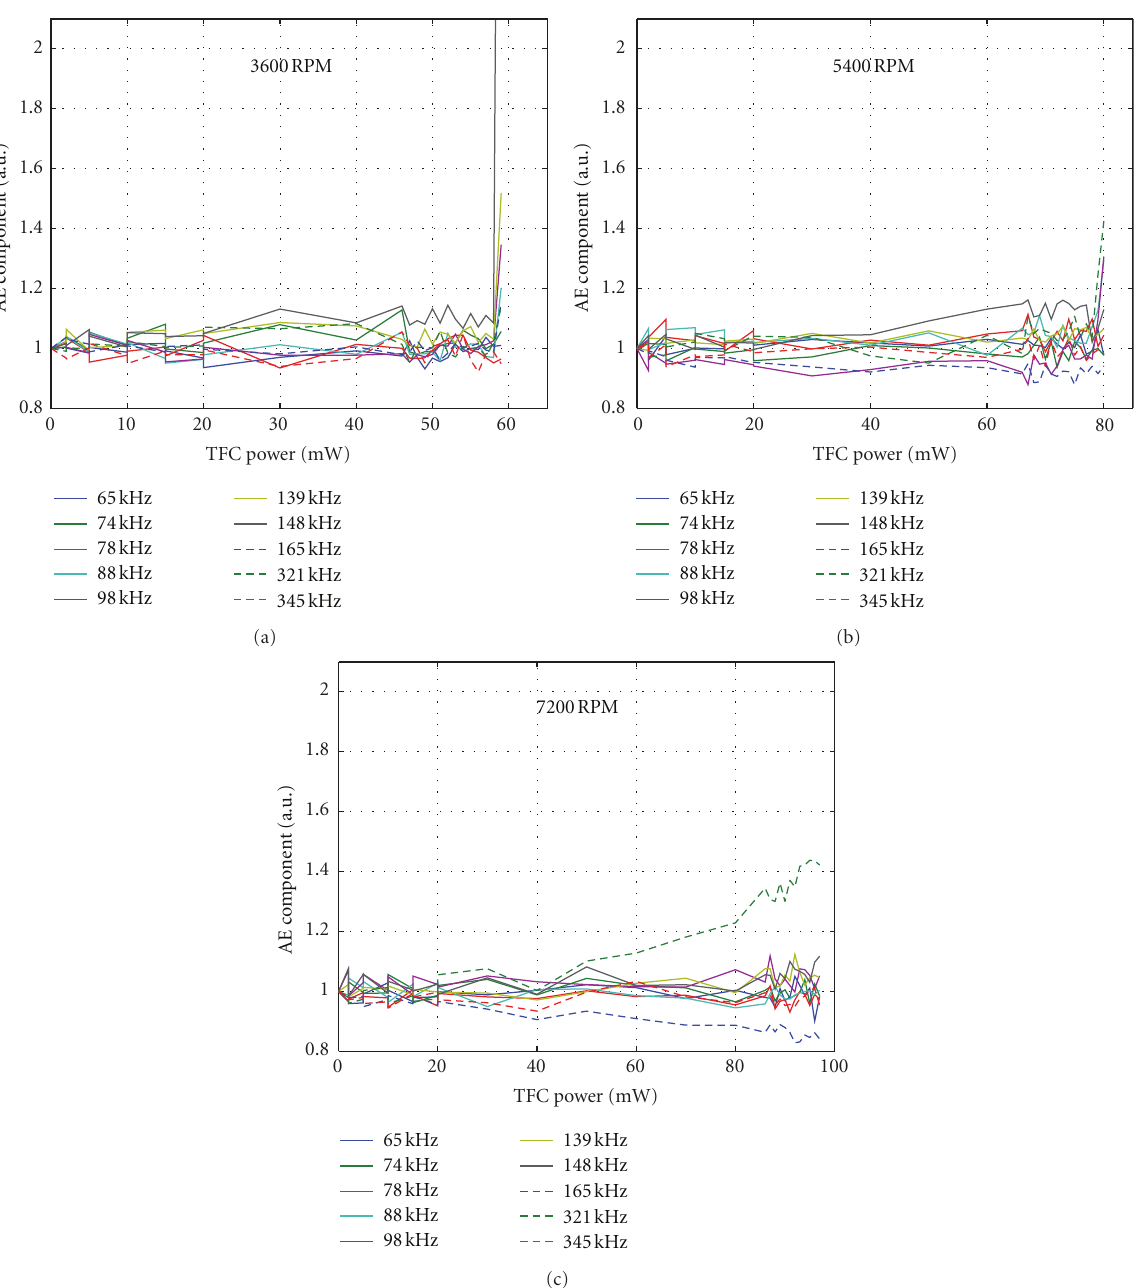
Figure 7: AE signal components in the touchdown plot for ABS-2 at di ff erent disk